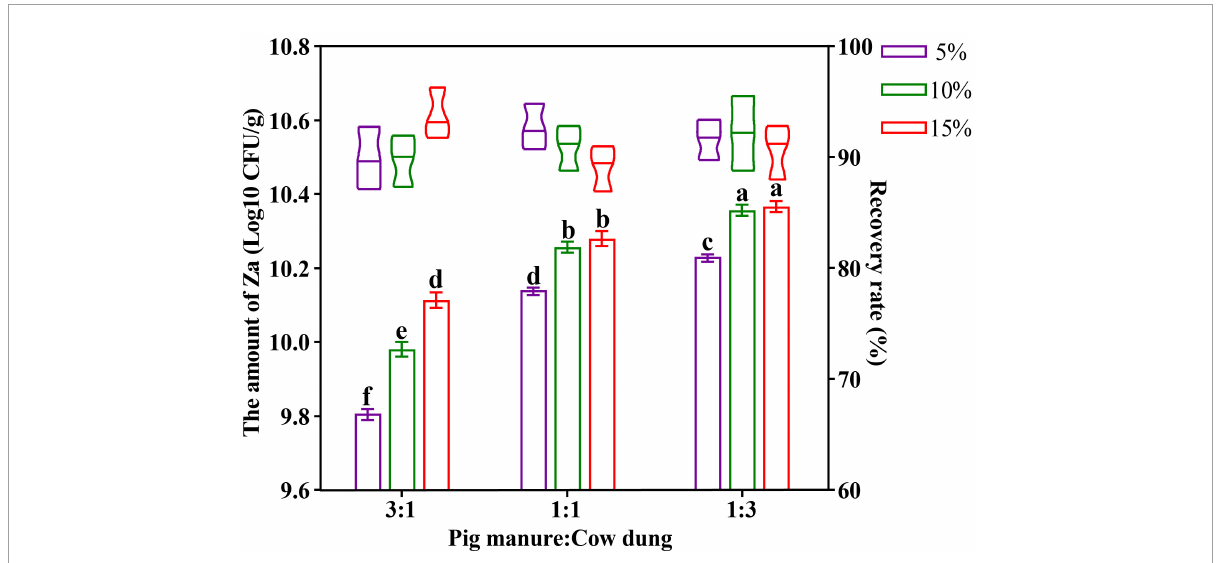
FIGURE1 Optimization of organic fertilizer carrier ratio and Za inoculum amount in preparation of solid agents. The abscissa represented the mixing ratio of the organic fertilizer carrier (pig manure: cow dung), the icon (5%, 10%, and 15%) showed the levels of strain Za inoculum, the amount of Za was shown as a bar graph, the recovery rate of Za was shown as the violin